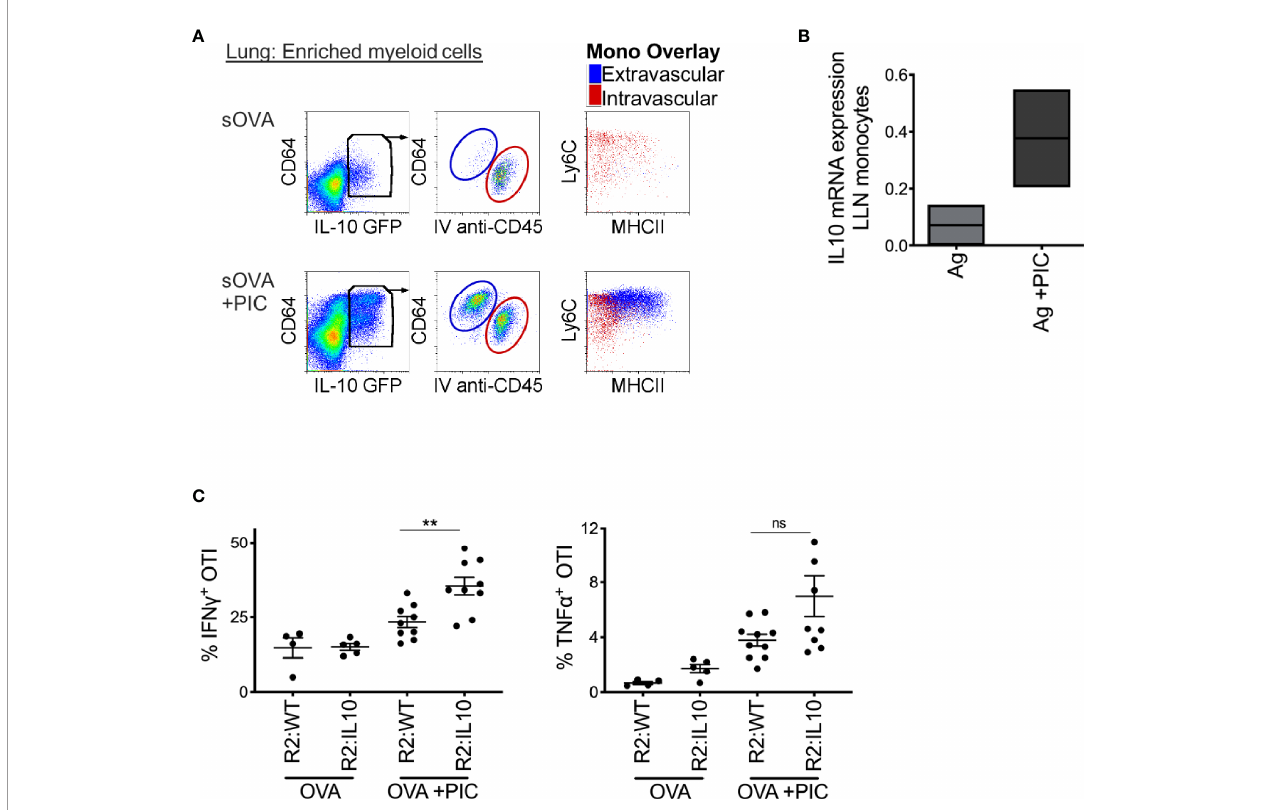
FIGURE 3 | Poly IC-induced IL-10 production by monocytes is required to suppress antigen-speci fi c CTL response. (A) IL-10 GFP reporter mice were inoculated i.n. with 2 m g OVA ±20 m g Poly IC. Five minutes prior to sacri fi ce and tissue harvest, 5 ul of anti-CD45 antibody was given intravenously. Lung monocytes were isolated and analyzed by fl ow cytometry for IL-10 expression, left plots. Middle plots illustrate gated IL-10 producing cells, where all extravascular IL-10 producing cells were CD64 + cells. Right plots display overlay of intravascular (red) and extravascular (blue) IL-10 producing cells, which were all CD64 + Ly6C + monocytes with extravascular monocytes displaying signs of maturation, up-regulation of MHCII. (B) Normalized mRNA expression of IL-10 in LLN of WT mice after i.n. immunization with 2 m g OVA ±20 m g Poly IC as outlined in Figure 1B . Box plot is the mean of two independent experiments. (C) Lethally irradiated mice were reconstituted 80:20 with CCR2 -/- and IL-10 -/- BM cells: R2:IL-10. Control mice were reconstituted 80:20 with CCR2 -/- and WT BM cells: R2:WT chimeric mice. Scatter plot analysis of cytokine frequency from R2:WT and R2:IL-10 chimeric mice. Datum is representative of two independent experiments. Data are shown as mean ± SEM. Each dot represents a mouse. **P value < 0.01. Non-signi fi cant